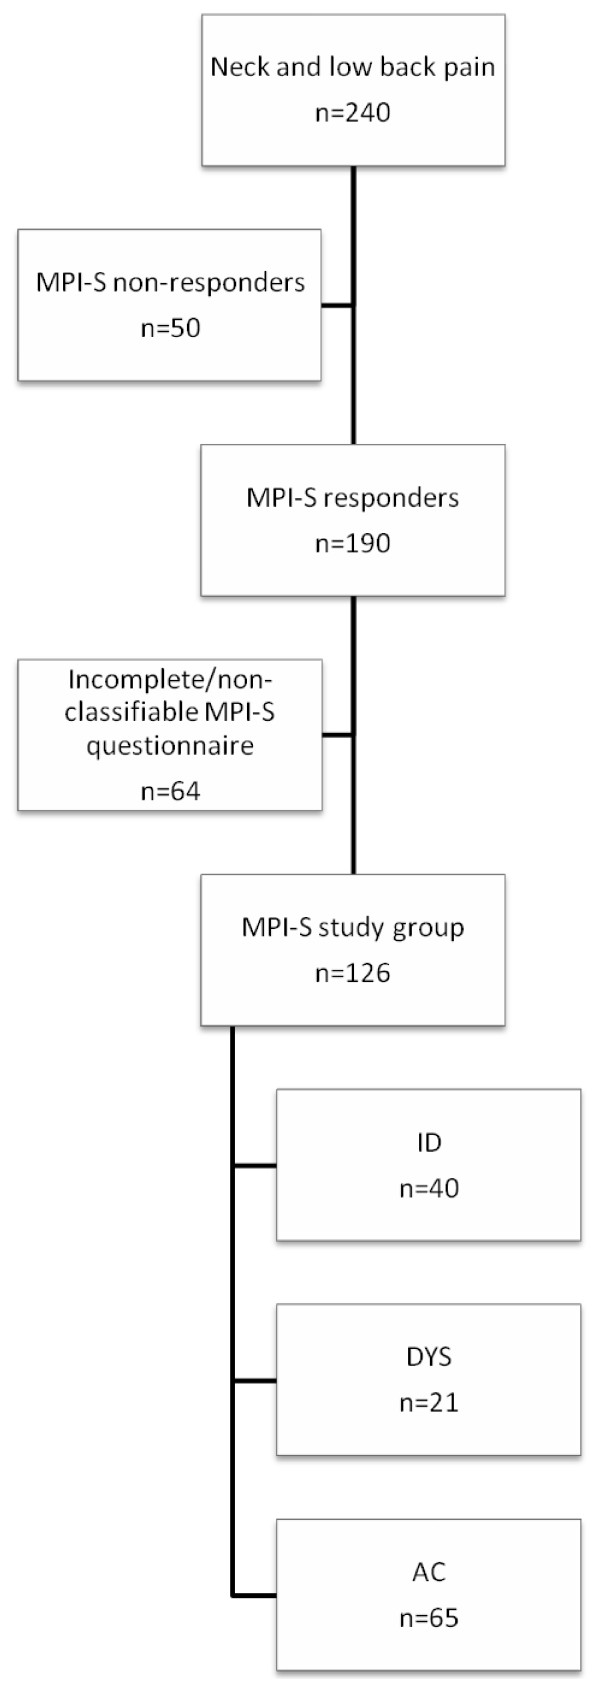
Selection chart of the study group.